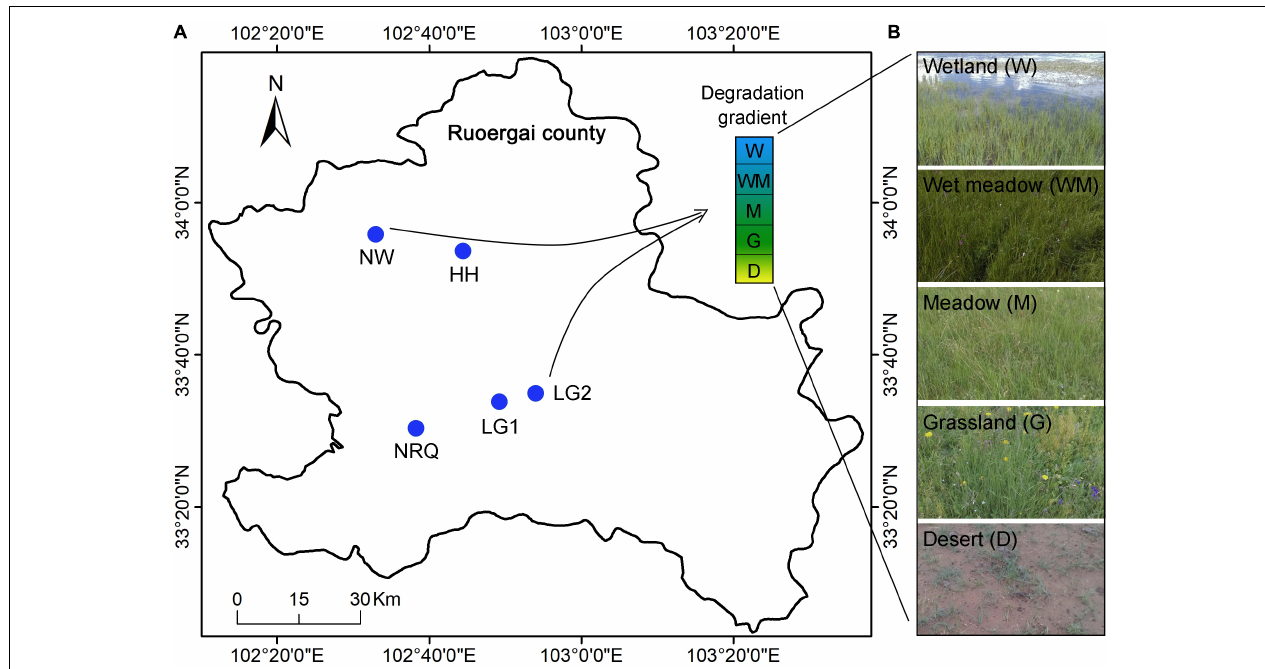
FIGURE 1 | Map of sampling (A) and vegetation (B) along degradational gradients of alpine wetland at Neng Wa (NW), Hua Hu (HH), Na Ruoqiao (NRQ), and Ling Ga (LG1 and LG2). W, typical wetland; WM, wet meadow; M, meadow; G, grassland; D,